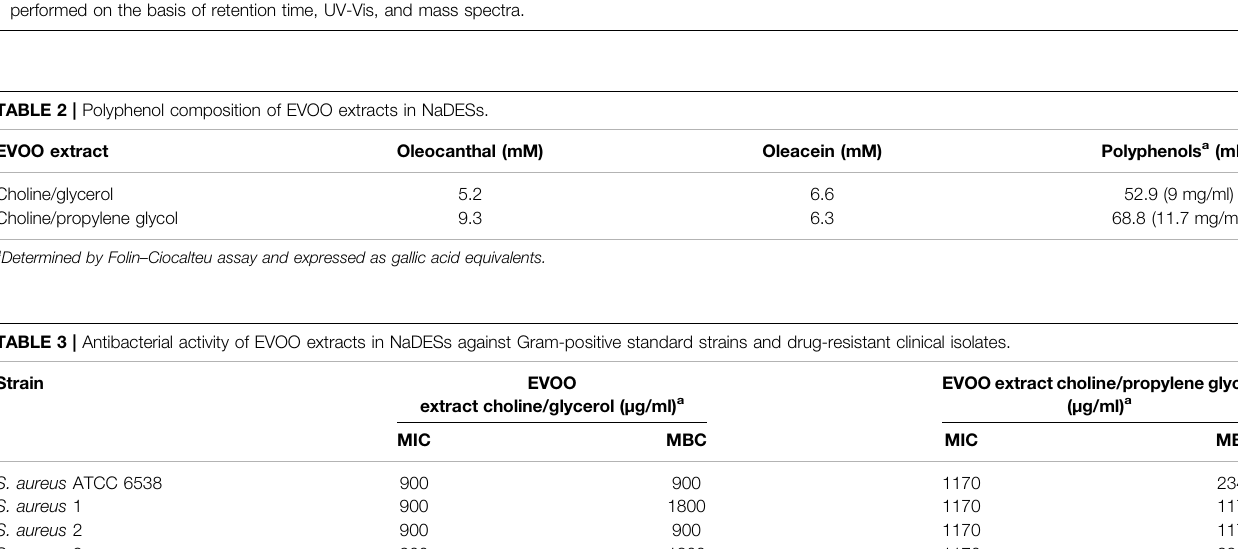
FIGURE1| Representativechromatographicpro fi leofapolyphenolicextractfromEVOO.Bluelinerepresentscholine:glycerolextract.Redlinerepresentscholine: propyleneglycolextract.EVOOextractwasdiluted1:100inwaterand10 µlanalyzed via UPLC/DAD/MSasdescribedinMaterialsandMethods.Peakidenti fi cationwas performed on the basis of retention time, UV-Vis, and mass spectra.